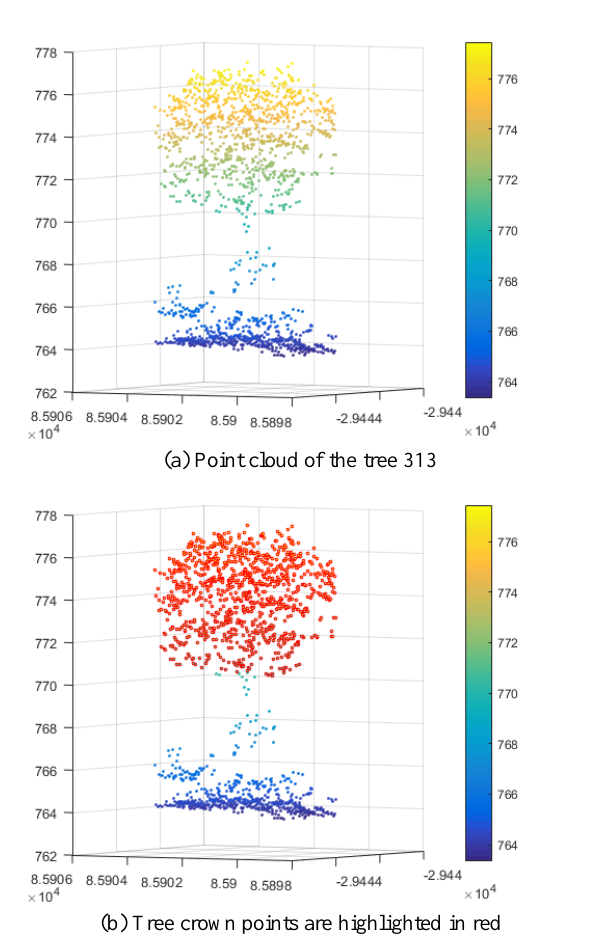
Figure 4. Example of tree crown point extraction